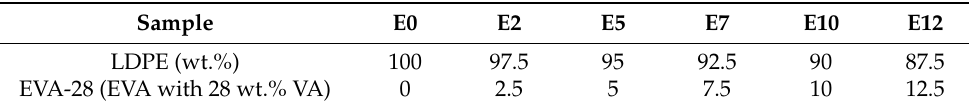
Table 1. Formulation used for the LDPE/ EVA-28 blends.